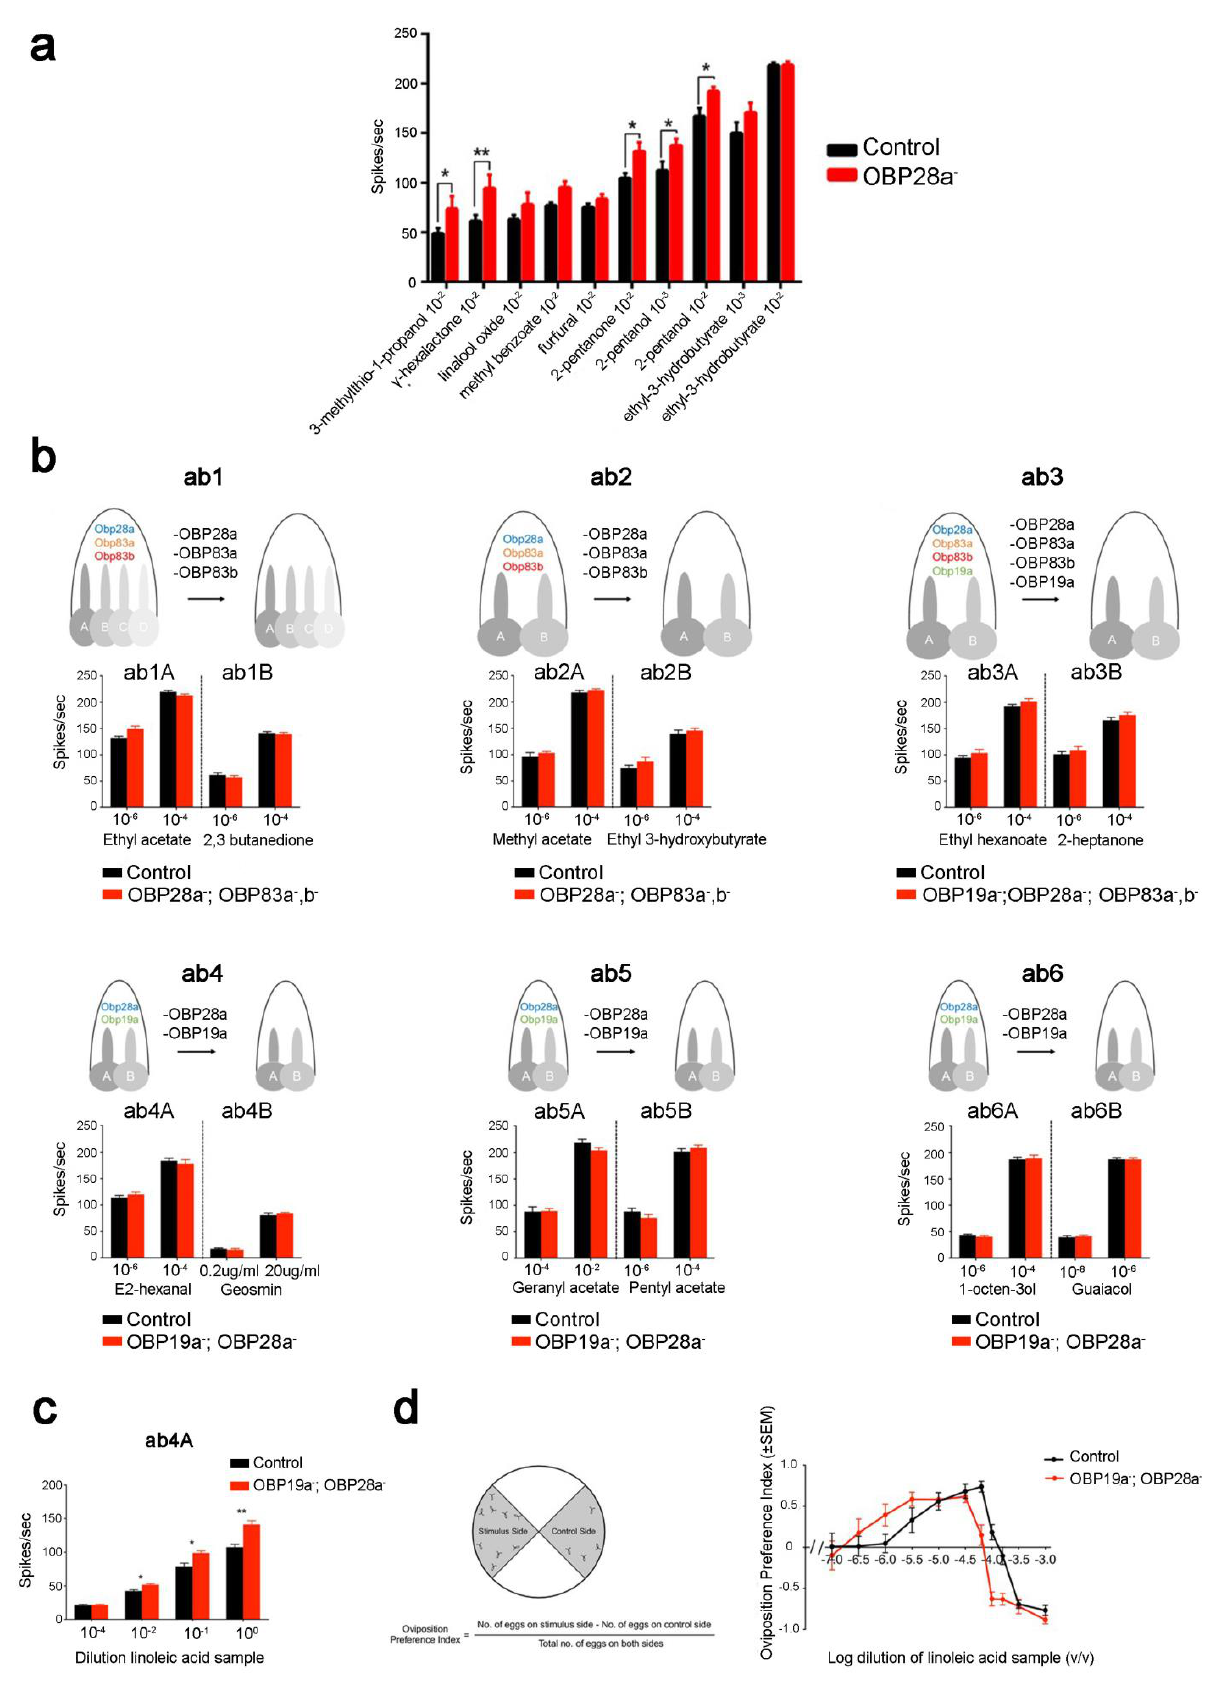
Figure 7. Role of OBP28a in the sensitivity of flies to general odorants. ( a ) Electrophysiological responses of ab8 neurons in control and OBP28a mutant flies to 0.5-s pulses of several chemical classes of odorants. Significant differences